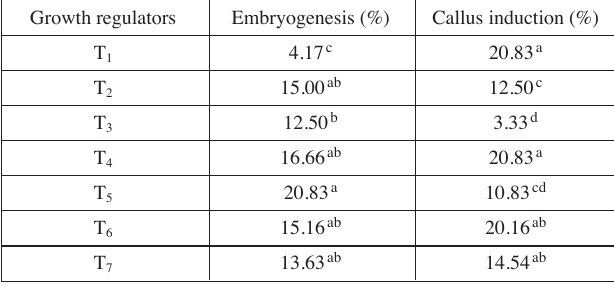
Tab. 6: Effects of different hormonal combinations on embryogenesis and callus induction in experiment